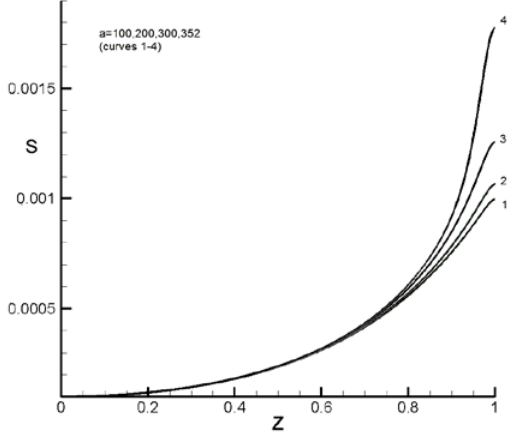
Fig. 1c. Stationary vortex lines for various subcritical transport currents [1] (here s is divided by a ).